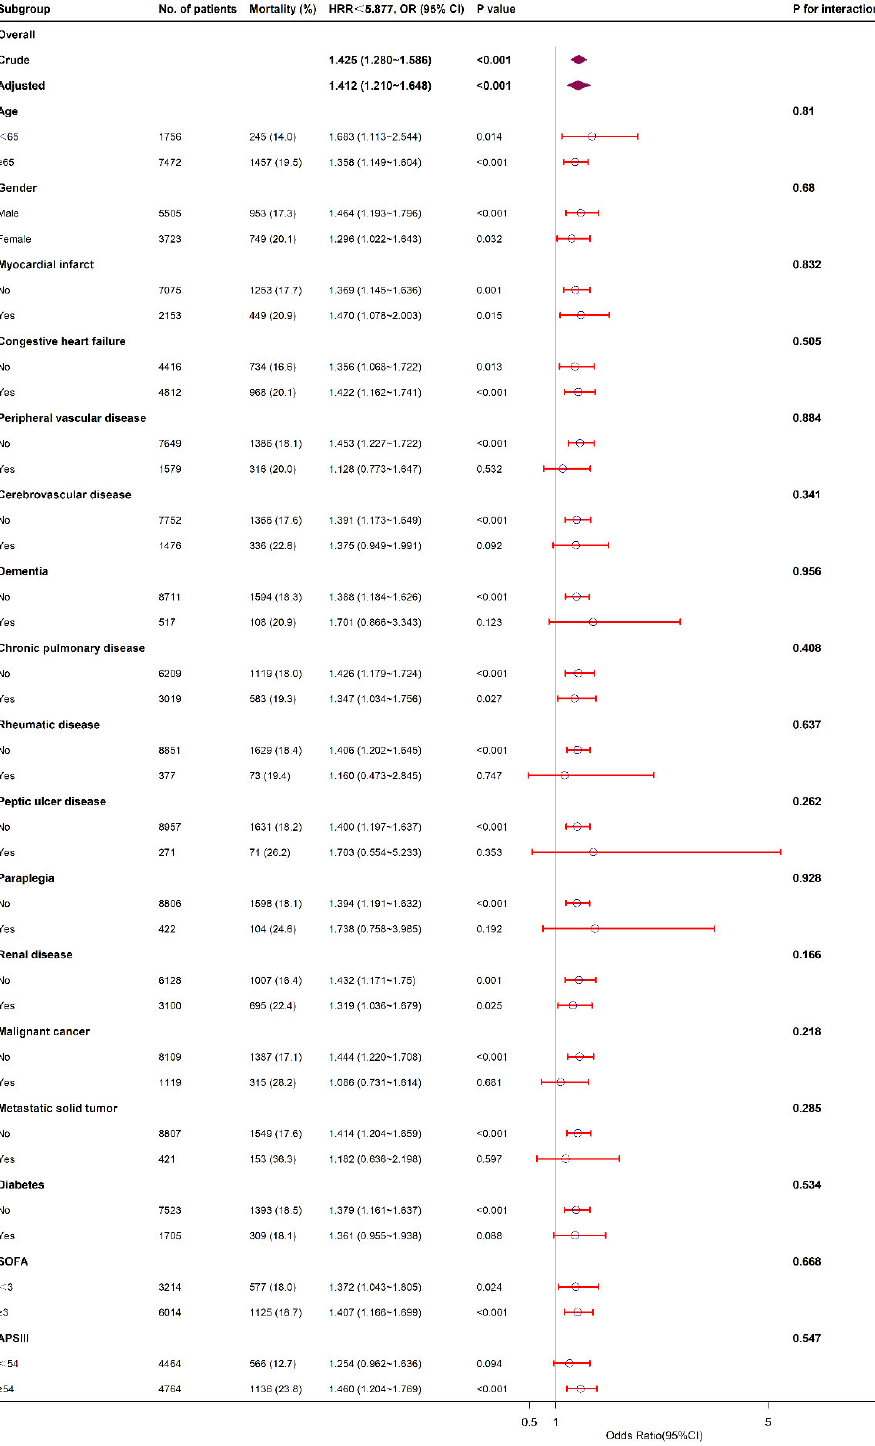
Figure 3. The relationship between HRR and in ‐ hospital mortality in subgroup analysis . and and represent the HR value. Red bands present the 95% confidence interval. 3.6. Prognostic Value of HRR after PSM